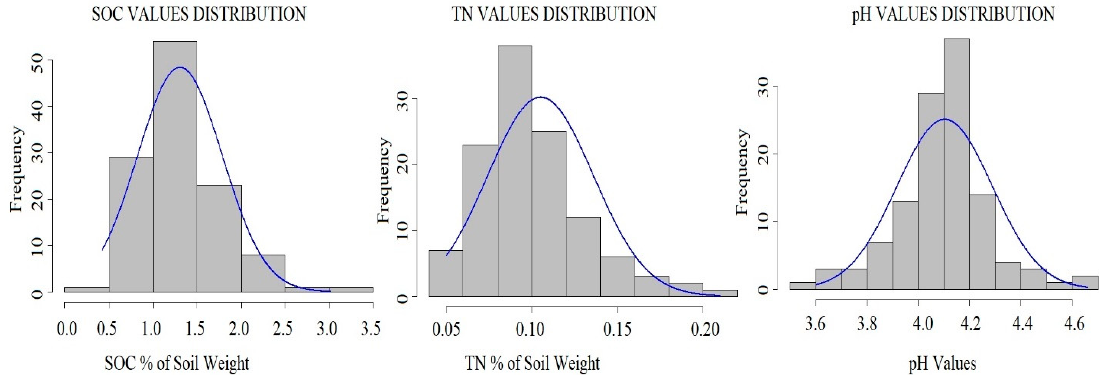
Figure 2. Soil quality indicator distribution.